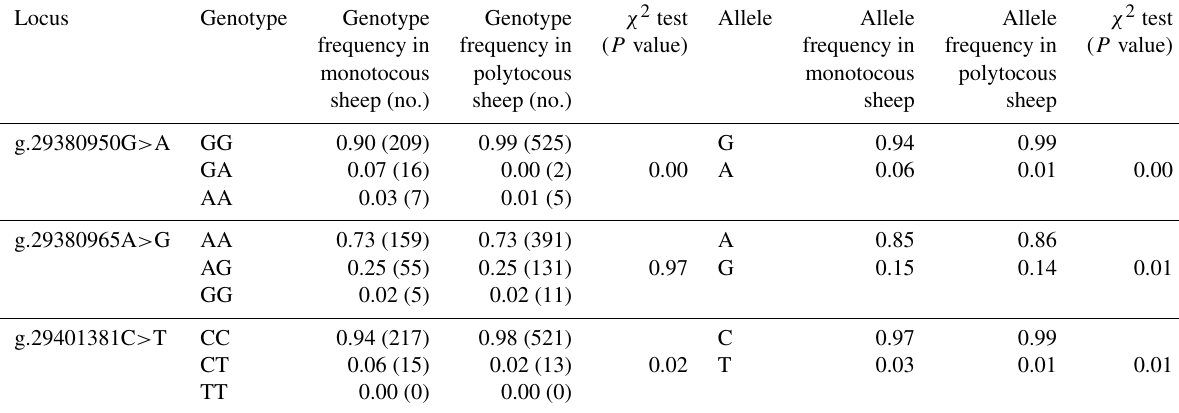
Table 3. Genotype and allele frequencies of three SNPs of the BMPR1B gene in monotocous and polytocous sheep. Locus Genotype Genotype